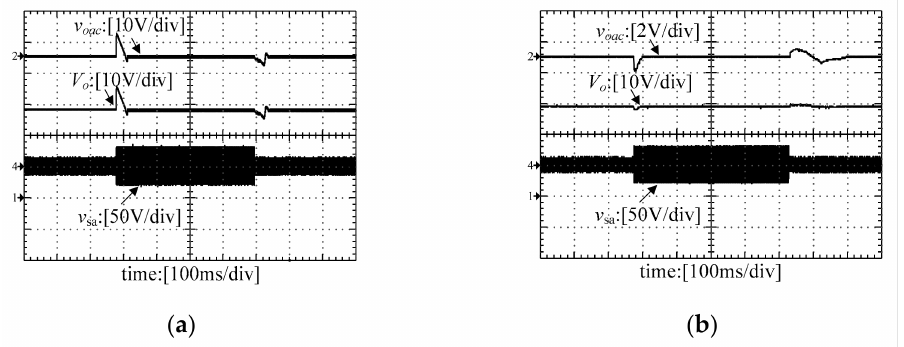
Figure 23. Experimental results of input voltage dynamic test. ( a ) Without IVFF. ( b ) With IVFF.